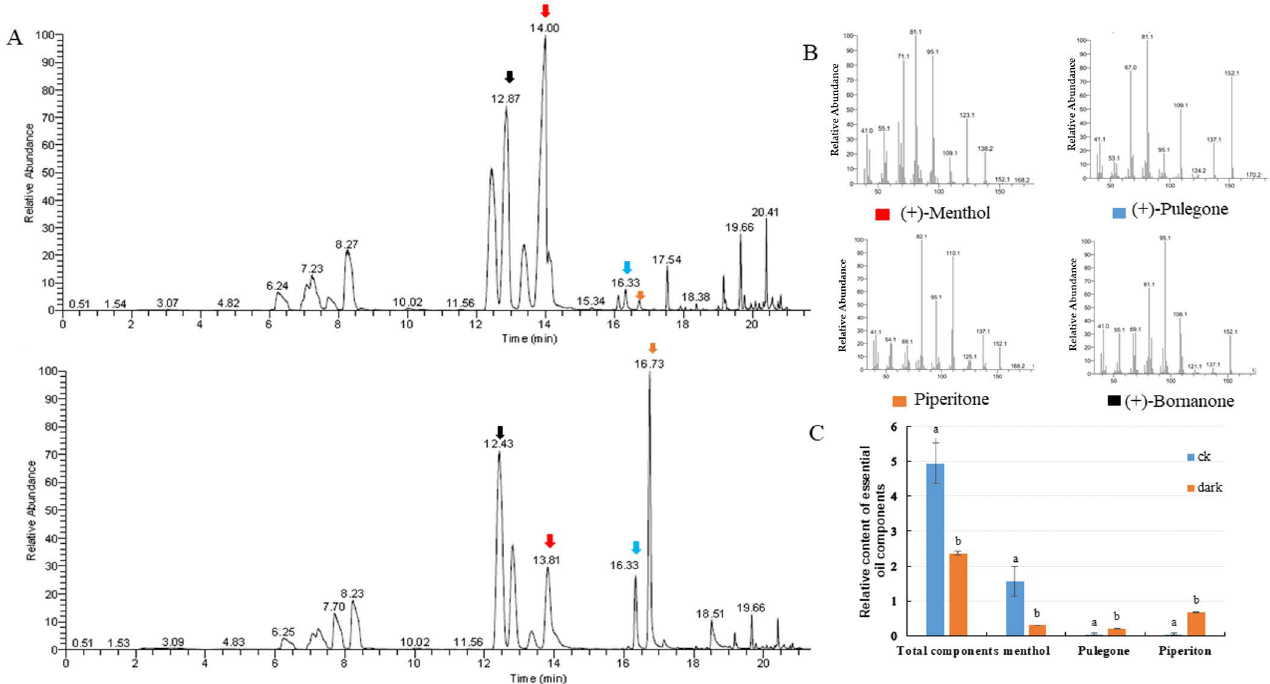
Figure 2. Introduction of changes in volatile exudates of leaves under the control and the low light conditions. ( A ) Gas chromatography–mass spectrometry (GC-MS) analysis of plants under the control (up) and low light (bottom) conditions. ( B ) MS/MS spectra of significantly changed compounds between the two light conditions, i.e., menthol, pulegone, piperitone, and the internal standard substance bornanone. ( C ) Relative contents of volatile compounds: menthol, pulegone, and piperitone. Table 1. The essential oil compositions of mint leaves ( Mentha canadensis L.) under the control and low light conditions. NO.